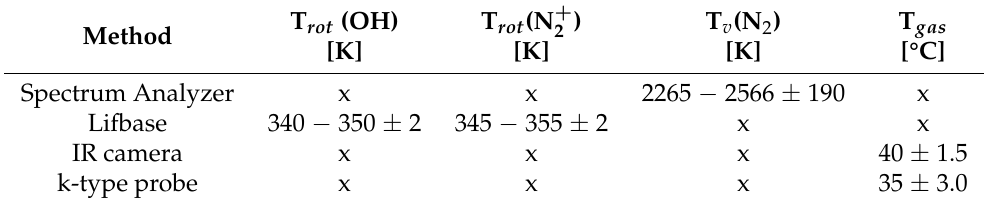
Table 3. Characteristic temperatures derived from the OES spectra of the plasma source and measured via IR and k-type thermocouple (mean ± standard